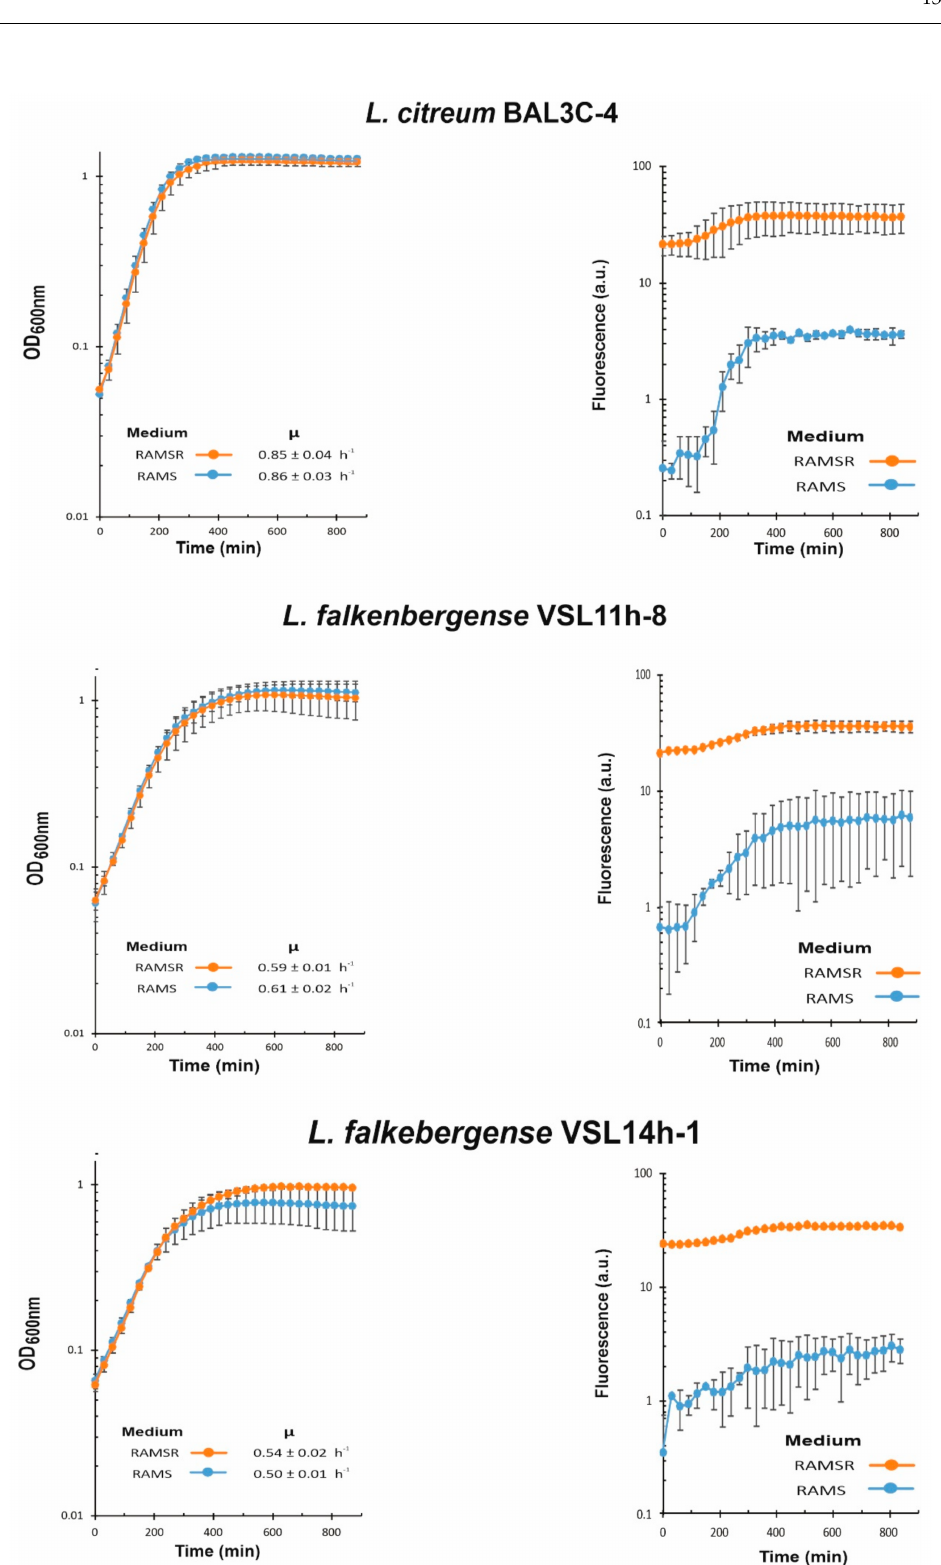
Figure 7. Detection of riboflavin production by Leuconostoc citreum BAL3C-4 and the L. falkerbengense strains. A comparative analysis in real time of lactic acid bacteria cultures grown in in RAM medium supplemented with either 2% sucrose (RAMS) or 2% sucrose plus 2% riboflavin (RAMSR) is depicted as in Figure 6. EPS and riboflavin levels present in the supernatants of the LAB cultures after growth for 22 h at 30 ◦ C in RAMS were also quantified (Table 2). The six LAB strains were able